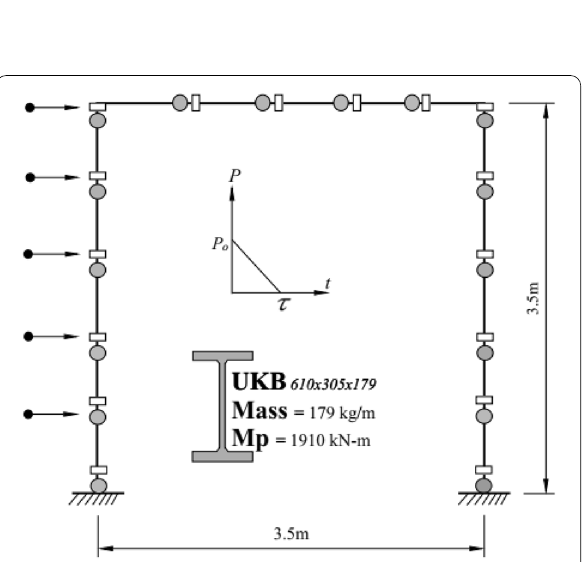
Fig. 18 Portal frame impelled by blast loading.